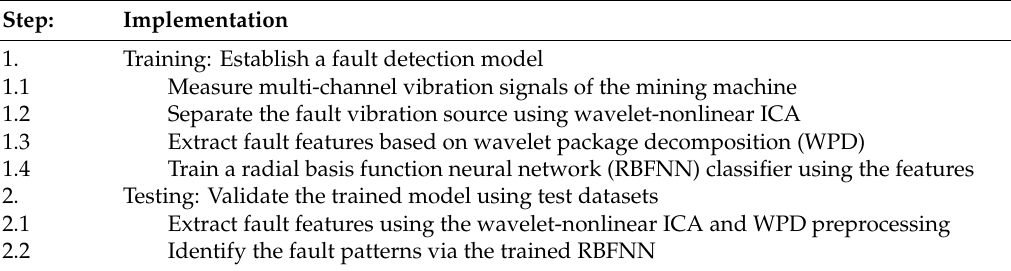
Figure 1. Process of fault diagnosis principle of mining machines. WPD, wavelet package Figure1. Processoffaultdiagnosisprincipleofminingmachines. WPD,waveletpackagedecomposition; decomposition; RBF, radial basis function; ICA, independent component analysis. RBF, radial basis function; ICA, independent component analysis. Table 1. Detailed implementation of the proposed Table 1. Detailed implementation of the proposed method.